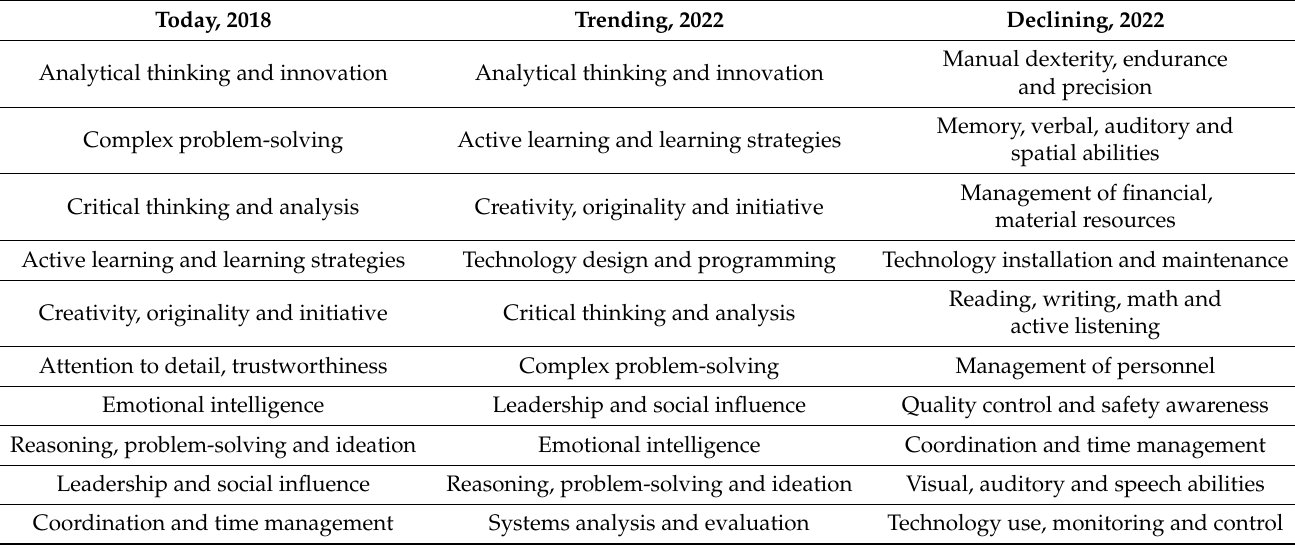
Table 1. Comparison of demand for skills, 2018 versus